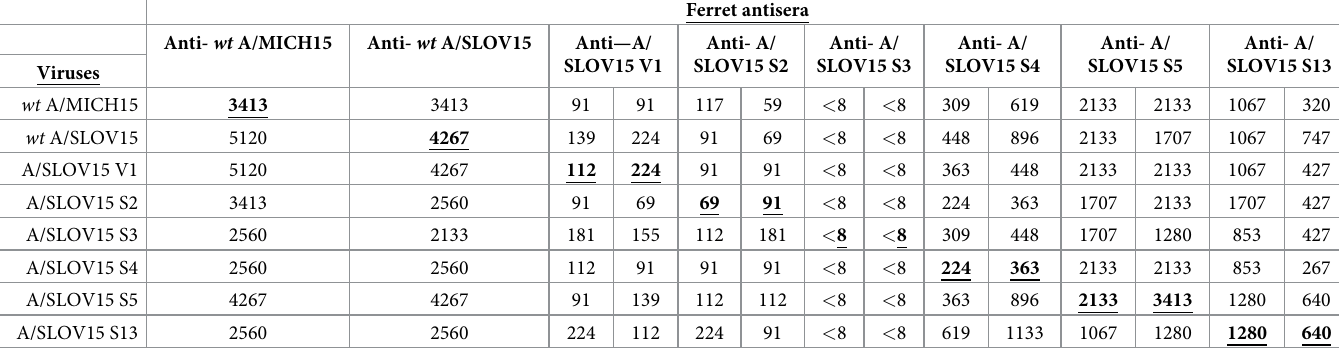
Table 2. Individual point mutations are antigenically similar to wt reference viruses when tested by two-way HAI, but show variable immunogenicity.